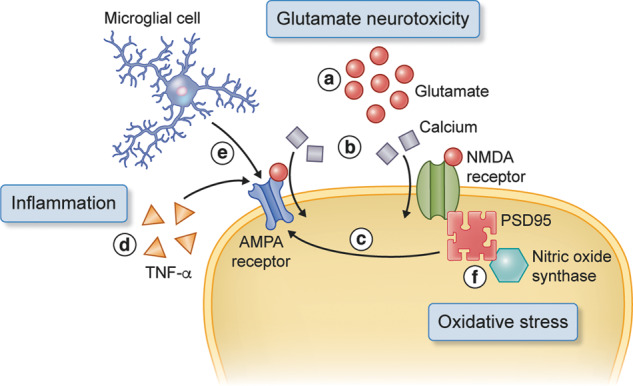

TBI secondary injury and the postsynaptic density. There is a surge of glutamate following TBI (a) (Vespa et al., 1998; Hong et al., 2001), which leads to influx of Ca2+ into the cell at the NMDA and AMPA receptors (b) (Nilsson et al., 1996). PSD95, which is bound to PKCα, promotes GluR2-deficient AMPA receptors and exacerbates TBI excitotoxicity (c) (Spaethling et al., 2008). The release of TNFα also acts upon the AMPA receptors and reduces expression of GluR2, which worsens excitotoxicity (d) (Beattie et al., 2002; Stellwagen et al., 2005). Triggered by CR3, microglia lead to long-term depression by activation of NADPH oxidase and GluR2-mediated AMPA receptor internalization (e) (Zhang et al., 2014). PSD95 is bound to neuronal nitric oxide synthase which plays a role in promoting oxidative stress (f) (Brenman et al., 1996).